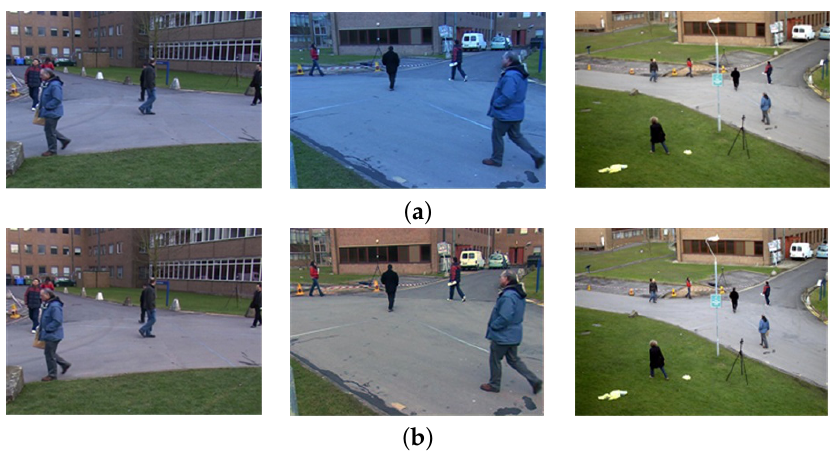
Figure 7. Results of color correction: ( a ) input images captured by three different cameras; and ( b ) color-corrected images using the shades of gray method.